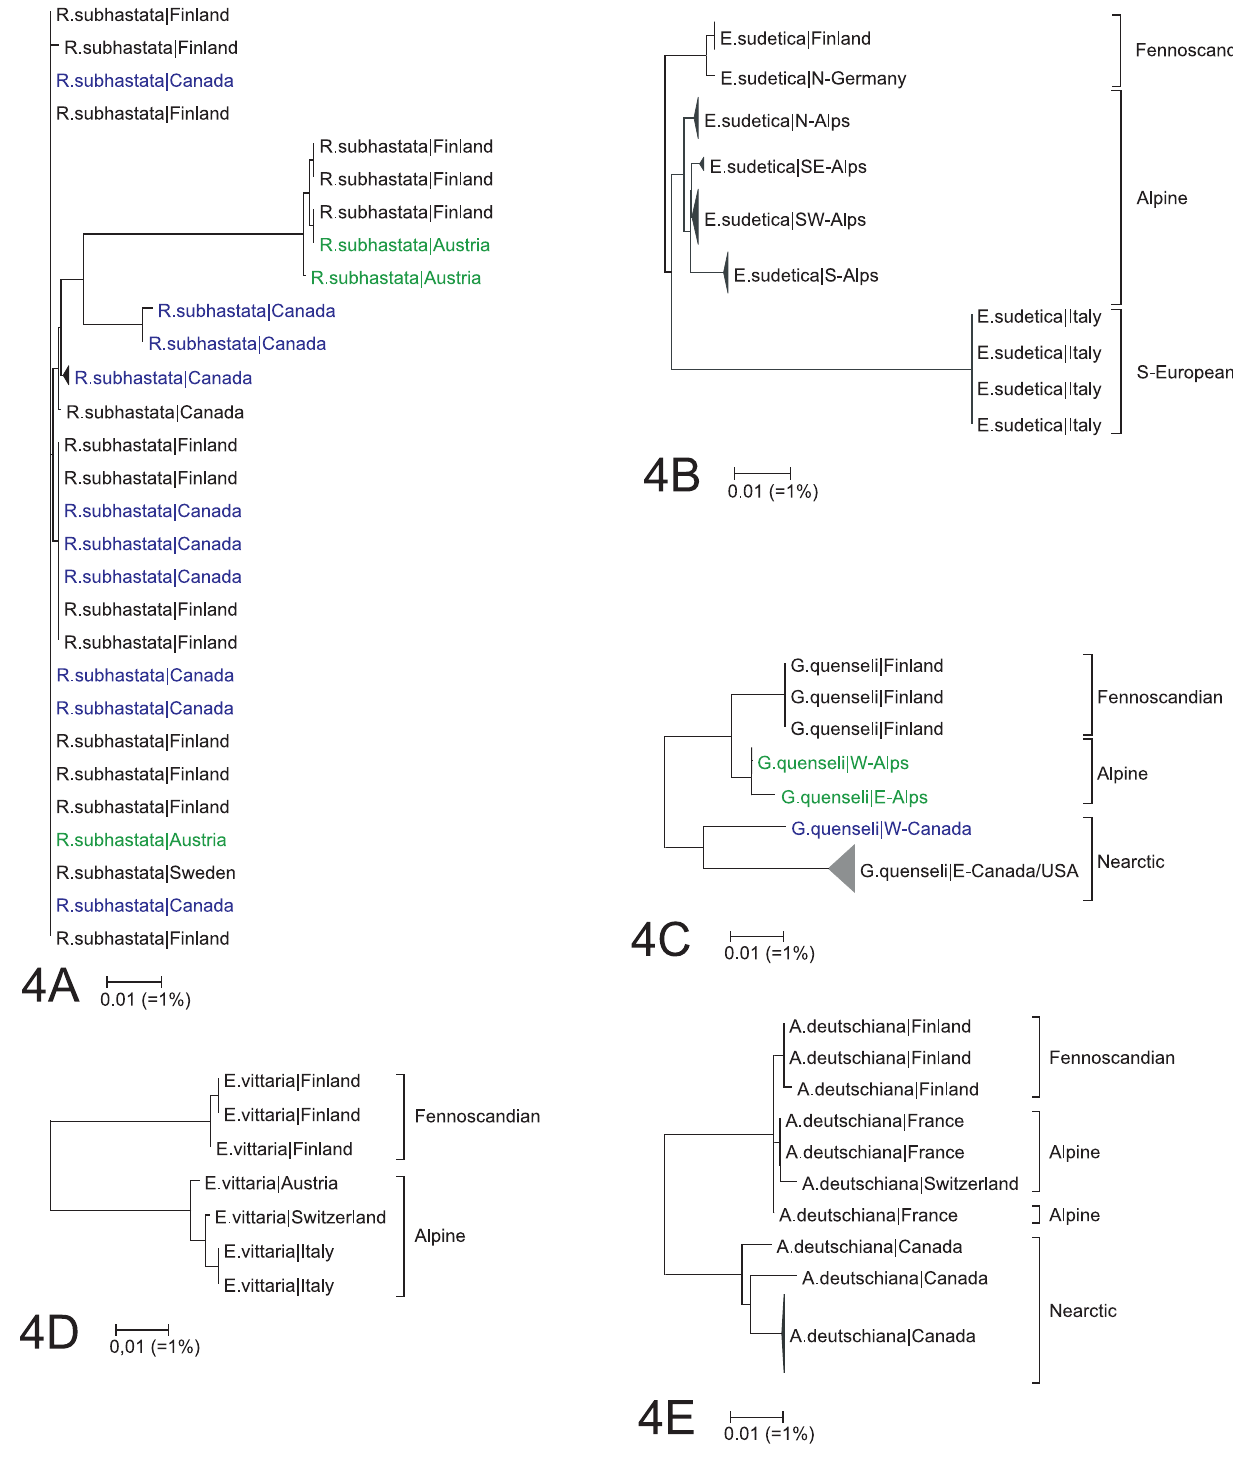
Figure 4. Species showing deep intraspecific splits within or between regions. 4A. Rheumaptera subhastata , 4B. Eudonia sudetica , 4C. Grammia quenseli, 4D. Elophos vittaria , 4E. Aethes deutschiana .